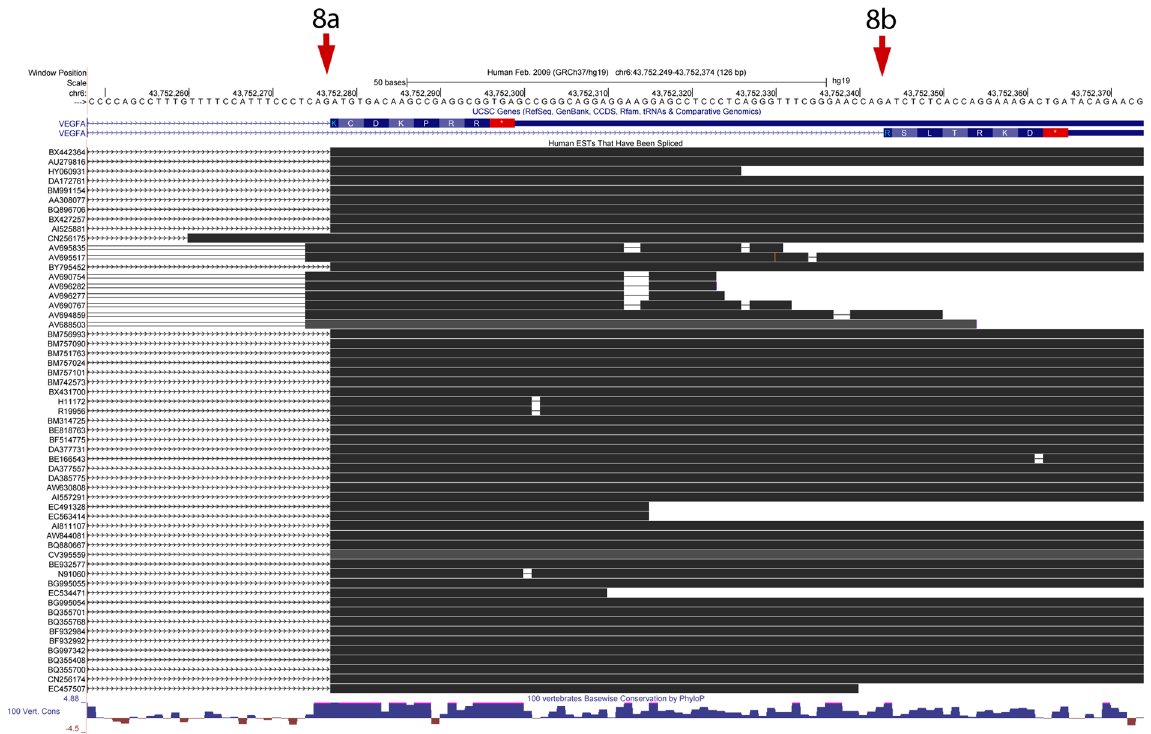
Figure 2. ESTs spanning the exon 8 splice junction viewed in the UCSC genome browser. All available spliced ESTs indicate the exclusive use of exon 8a, with none supporting the existence of exon